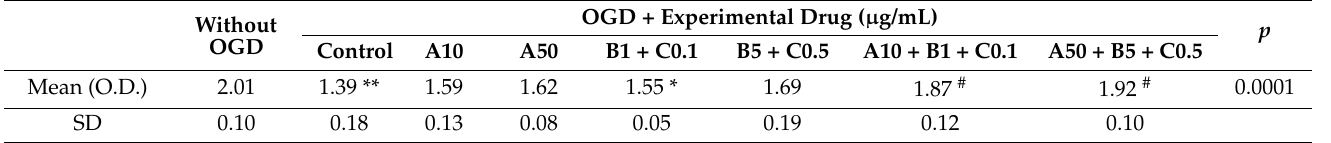
Table 3. Effects of the experimental drugs on cell viability (MTT assay) after OGD in SH-SY5Y cells ( n =